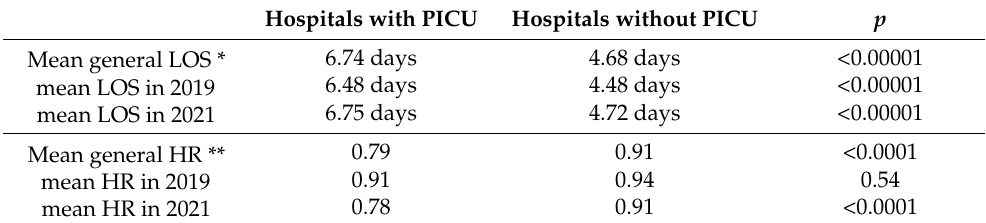
Table 4. Comparison in LOS and HR between hospitals with PICU and hospitals without PICU in 2019 and 2021.